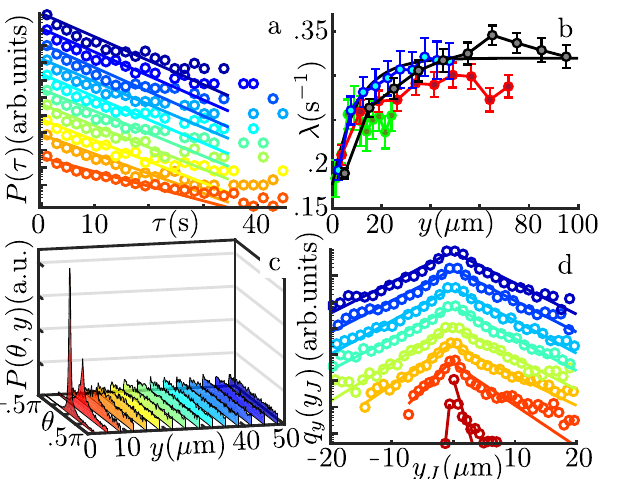
Fig. 3 | Comparison between experimental results and the jump-diffusion model. Steady-state colloidal probability distribution functions in a 2 W =100 μ m channel:experiments(circles);fulldynamics(black solidline); constant encounter rate ( λ ( y ) := bulk value) (teal dashed line); no thermal diffusion ( D 0 =0) (purple dashed line); homogeneous and isotropic jump size distribution ( q y ( y J ):=bulk dis- tribution) (orange solid line); analytical model (olive solid line). The analytical model curve has been shifted downward for clarity. Inset: characteristic jump size away from the boundary ( L + ( y ), red circles) and toward the boundary ( L − ( y ), blue ffiffiffiffiffiffiffiffiffiffiffiffi p derivedfrom circles)togetherwiththe fi rstandsecondmoments m 1 ( y )and m 2 ð y Þ them (Eq. (5)). Solid lines are fi tted heuristic analytical functions used to recon- struct the colloidal distribution (see Methods). Error bars propagated from fi t uncertainties.